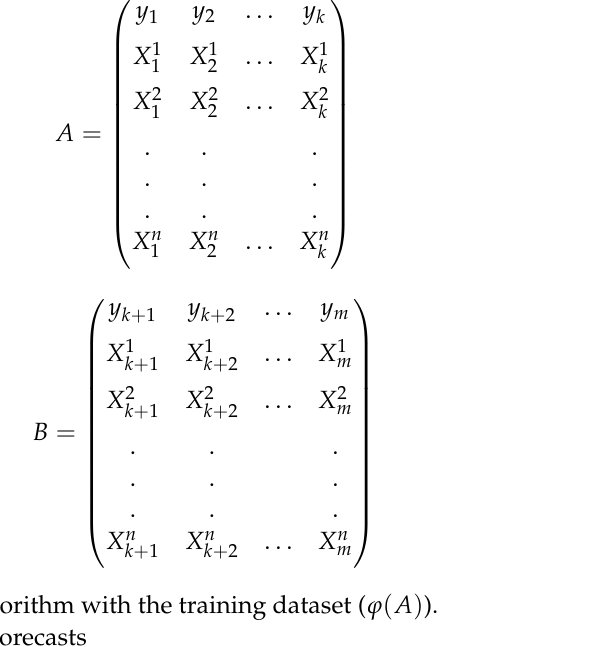
using the testing dataset and the trained algorithm ( ϕ ( B ) ) 5. Estimate the accuracy of the forecast ( YP ) comparing it with the actual values